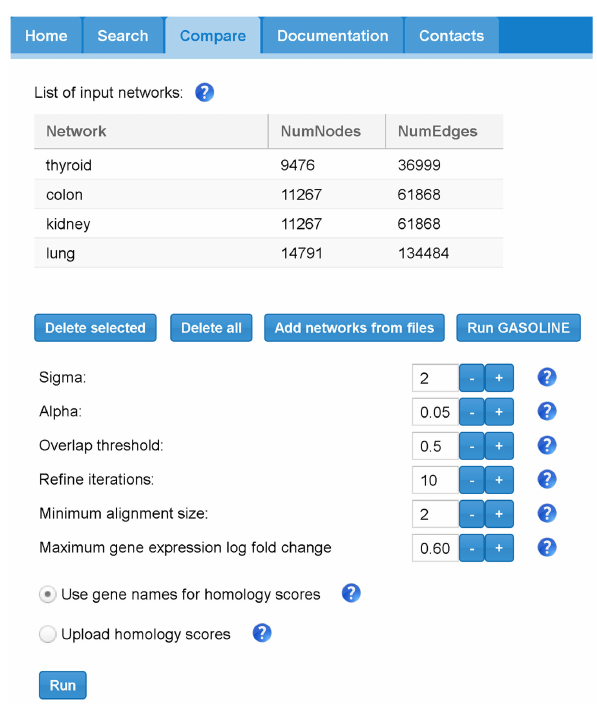
By selecting an alignment, its details are reported on the right ( Figure 9 ). Alignment data include the set of nodes and edges attributes. The final mapping of aligned nodes is represented as a matrix in which columns contain nodes of the same network and rows represent the mapped